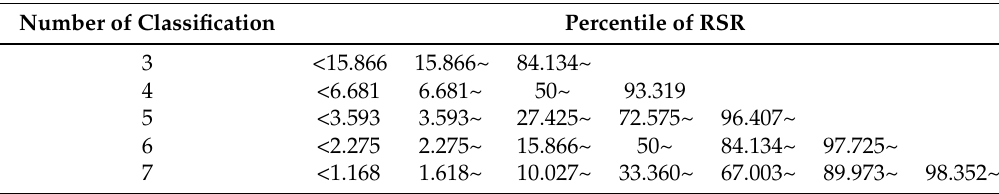
Table 1. Percentile of Rank Sum Ratio (RSR) classifications a